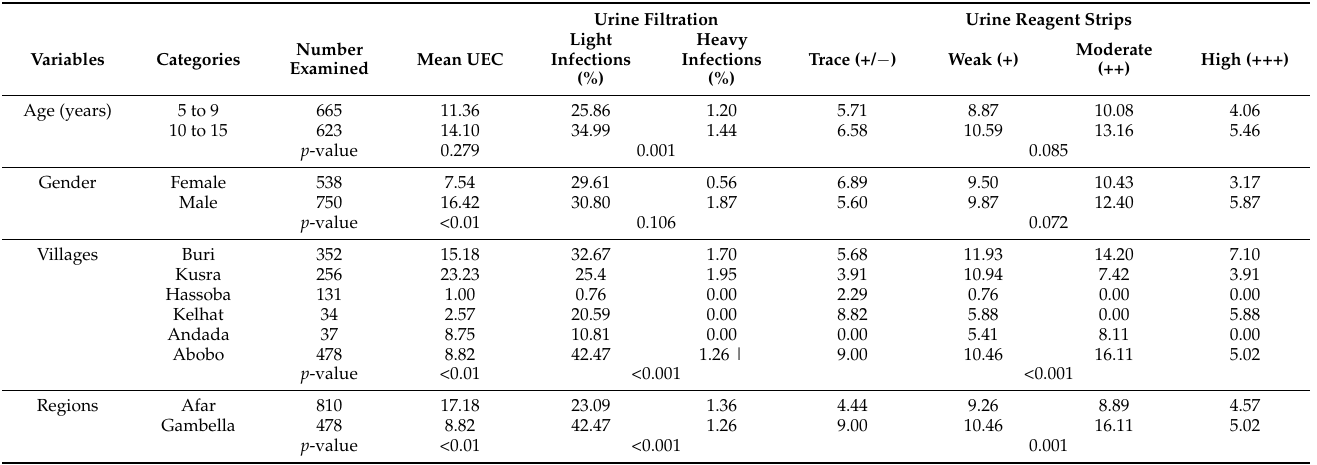
Table 2. Intensity of Schistosoma haematobium infection among school-age children in Afar and Gambella Regional States of Ethiopia, October 2021 to April